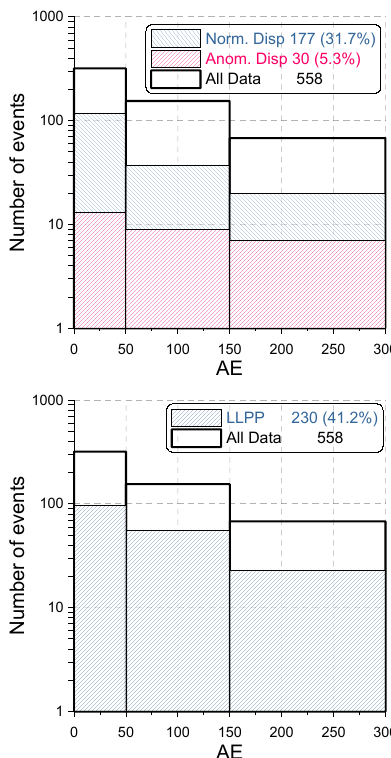
Figure 9. MLT distributions of the latitudinal shift between IBs at 30 and 80keV for normal dispersion events (dIB, bottom) and be- tween poleward-most and equatorward-most IBs at 30keV in the group of multiple structured IBs (IB0–IB2,